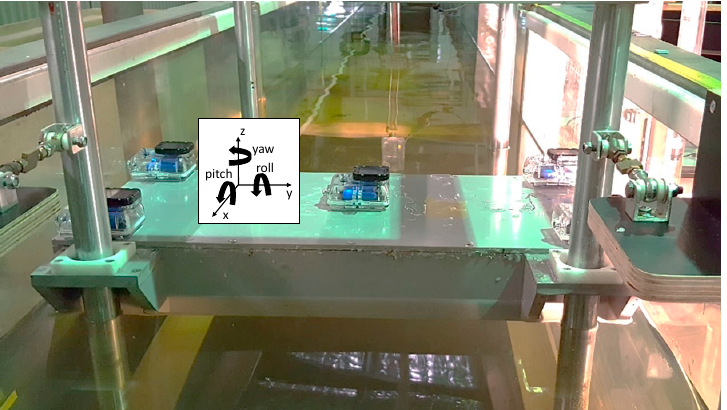
Figure 2. Photo of Narrow Pontoon Showing Seaward Face, Pile Mooring System and Positioning of Five IMU. The 6-degrees of freedom are also shown.